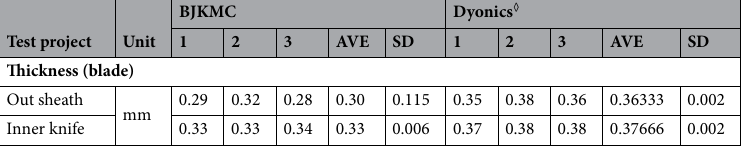
Table 4. The data of thickness of the